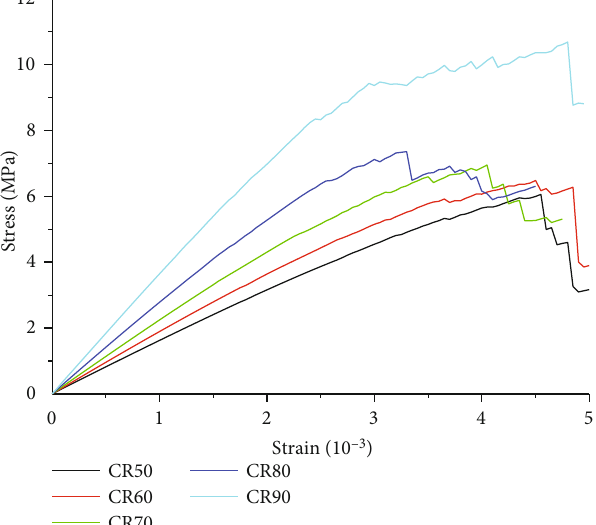
Figure 6: Stress-strain curves of samples with di ff erent coal-to- rock height ratios without water pressure.